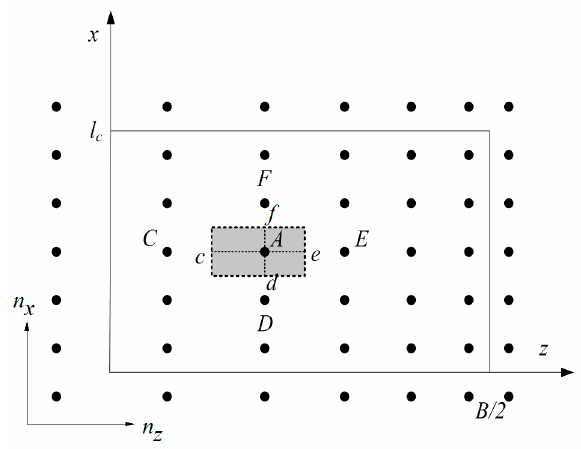
Figure 8. Dispersion of the deformation zone of the strip.